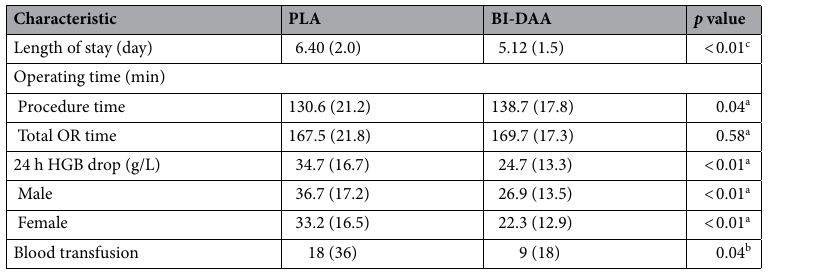
Table 2. Perioperative outcomes in total hip arthroplasty. Values are n (%) or mean (SD). p value < 0.05 considered statistically significant. BI-DAA bikini-incision via direct anterior approach, PLA posterolateral approach, SD standard deviation. a Student’s t test; b Chi-squared test; c Mann-Whitney U-test.